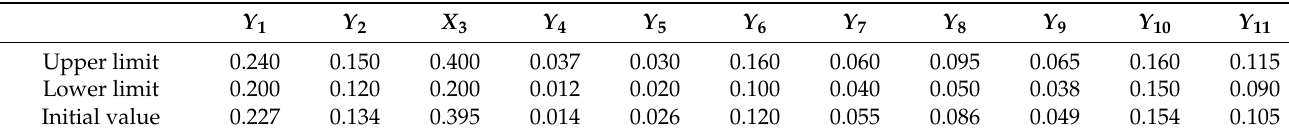
Figure 11. Locations of 11 variable points. Table 4. Settings for design variables.